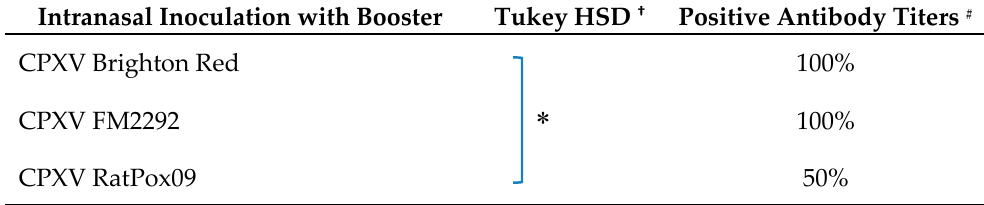
Table 7. Seroconversion rate of bank voles repeatedly inoculated with the same CPXV strain at 42 dpi. Intranasal Inoculation with